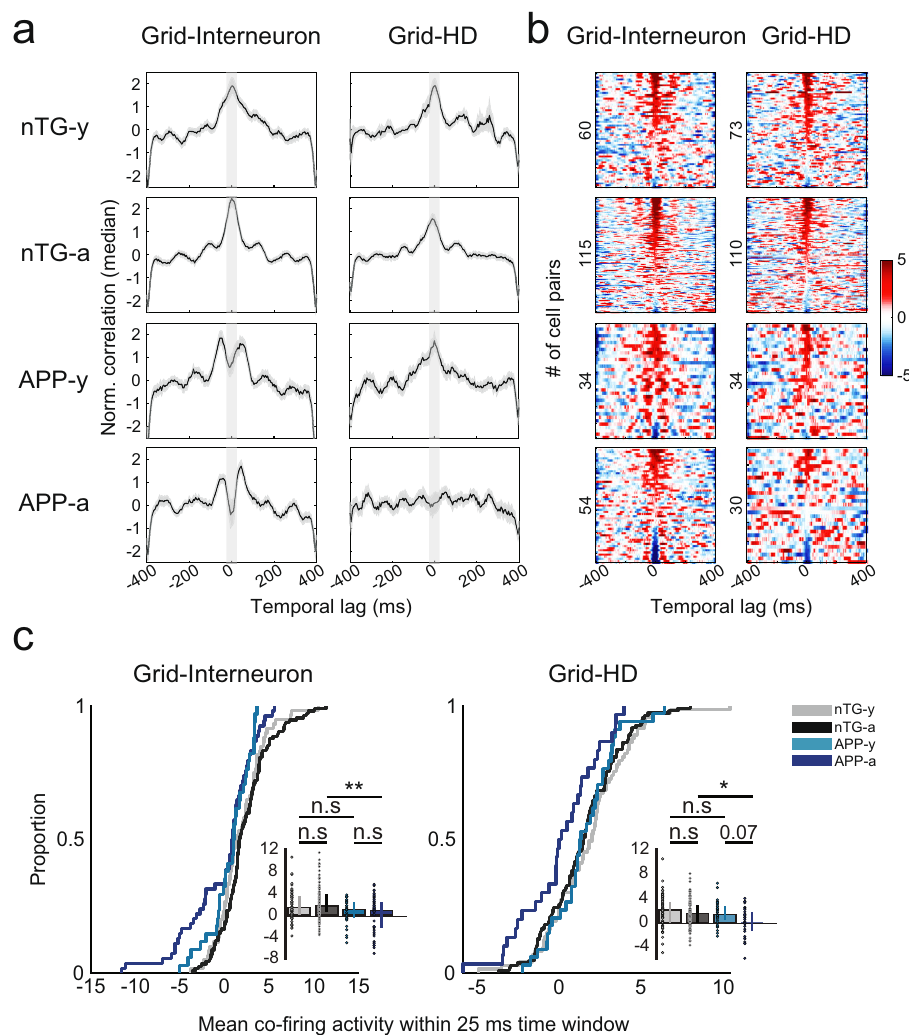
Fig. 4 Reduced spike-time synchrony in grid cell-interneuron and grid cell-head-direction cell pairs. a Spike-time cross-correlations between grid cell- interneuron pairs (left) and grid cell-head-direction cell pairs (right) for all experimental groups (rows). Each panel displays the normalized correlation (by median) by time lag (in ms). Black curves indicate median values and gray contours indicate median absolute deviation. Lighter gray columns indicate the 25 ms time window in each lag direction from 0 ms. b Color-coded raster plots show the magnitude of co-activity within a 400 ms time window. Y -axes are sorted in descending order by cell pairs with the maximum co-activity within a 25 ms time window, and numbers indicate the number of cell pairs in each experimental group. c The mean co-activity within a 25 ms time window for grid-interneurons pairs (nTG-y-nTG-a: P = 0.30; nTG-y-APP-y: P = 0.13; APP- y-APP-a: P = 0.51; nTG-a-APP-a: P = 0.0018), and grid-head-direction pairs (nTG-y-nTG-a: P = 0.33; nTG-y-APP-y: P = 0.56; APP-y-APP-a: P = 0.078; nTG-a-APP-a: P = 0.038) between groups (grid-interneuron pairs, n = 60 nTG-y; n = 115 nTG-a; n = 34 APP-y; n = 54 APP-a; grid-head-direction pairs, n = 73 nTG-y; n = 110 nTG-a; n = 34 APP-y; n = 30 APP-a). nTG-y non-transgenic young, nTG-a non-transgenic adult, APP-y APP young, APP-a APP adult. Wilcoxon rank-sum tests (two-sided) corrected for multiple comparisons using a Bonferroni-Holm correction were applied to analyze the data in panel c . Data in bar graphs are presented as median values± 25th and 75th percentiles; * P < 0.05, ** P < 0.01; n.s not signi fi cant. Source data are provided as a Source Data fi